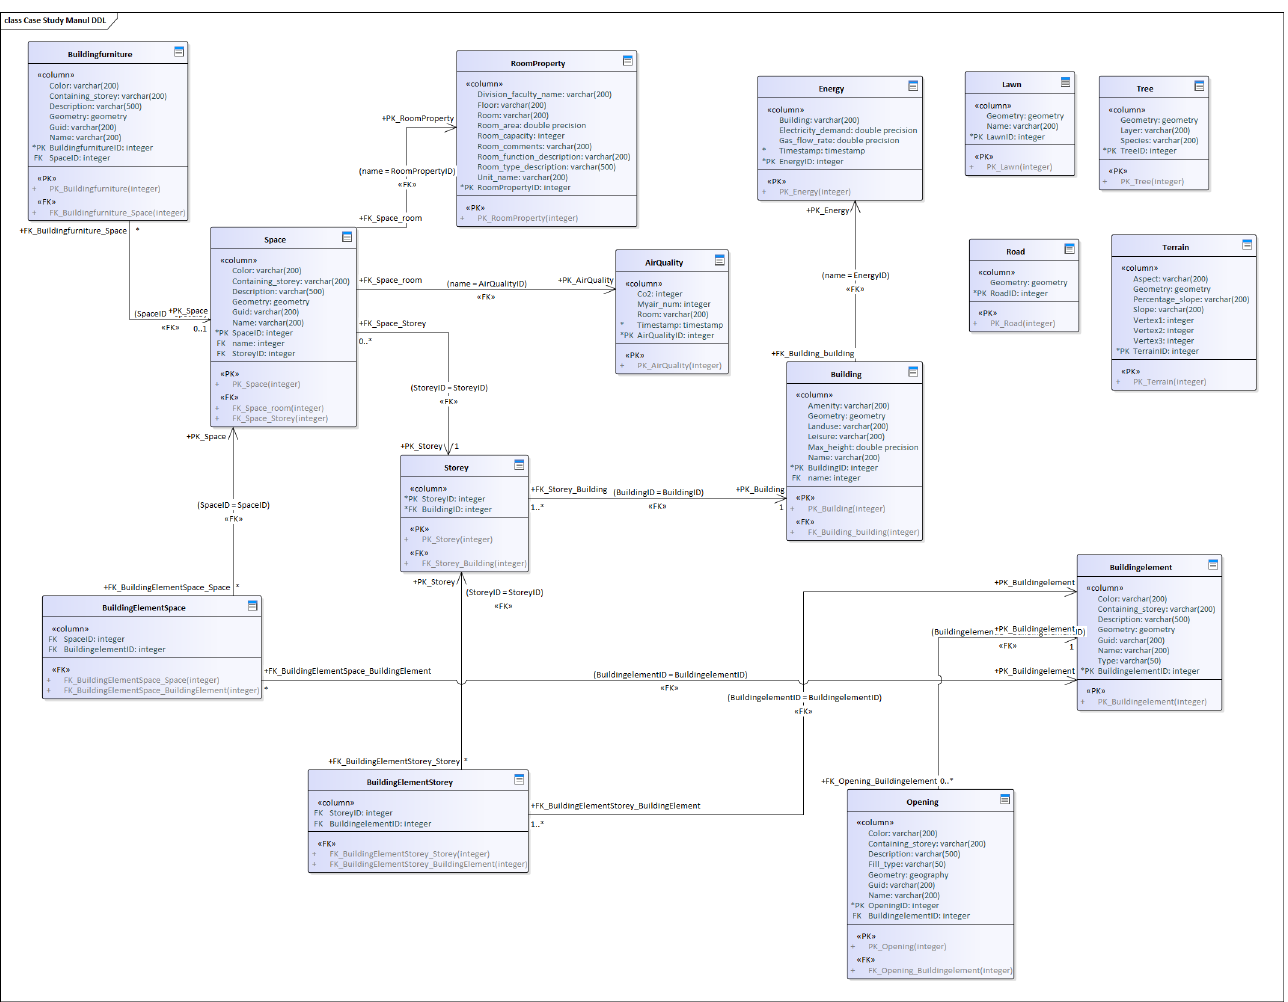
Figure 16. Logical data model for our relational database